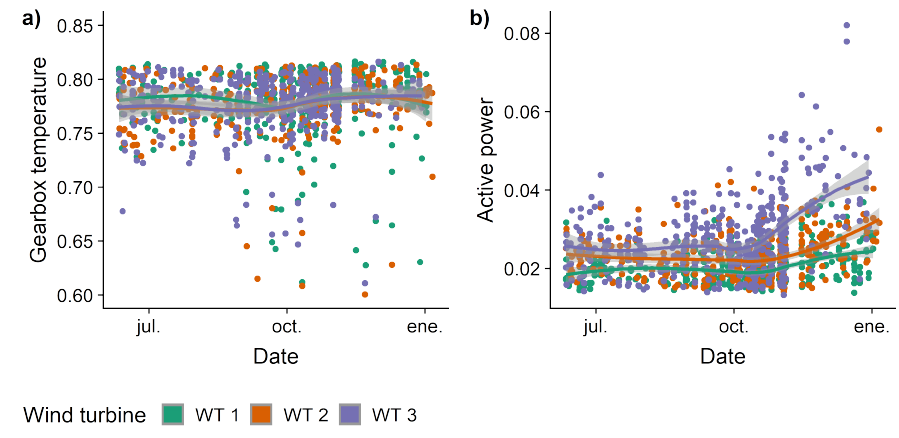
Figure 10. RMS values of different variable OSs throughout the time, generated using type Nominal OR. Curve is obtained by local regression (LOESS) smoothing. ( a ) Gearbox temperature. ( b ) Active